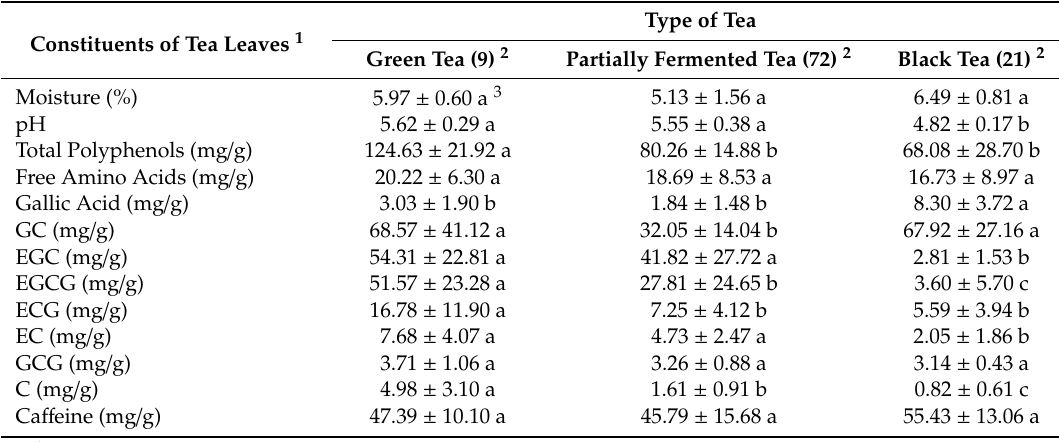
Table 2. Concentrations of constituents in green teas, partially fermented teas, and black